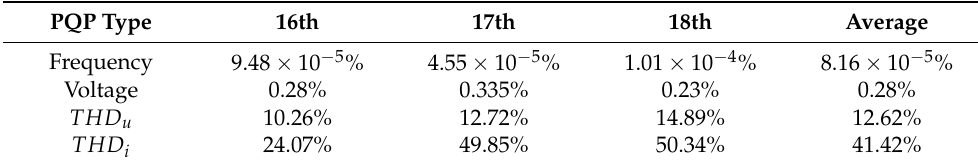
Table 7. Forecasting error (MAPE in %) for 16–18 August 2021, when using LR.